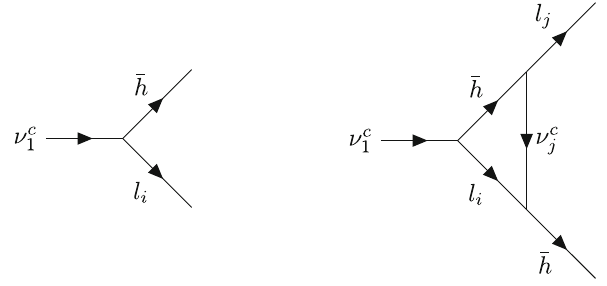
Fig. 2 Standard contributions to the generated lepton asymmetry